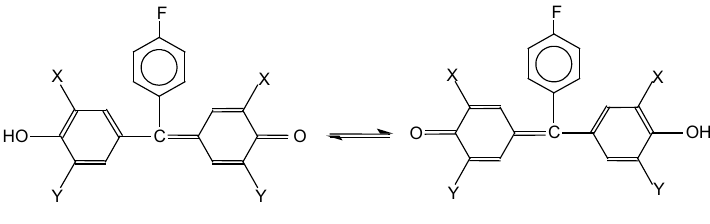
Figure 4. Tautomers of 15 - 18